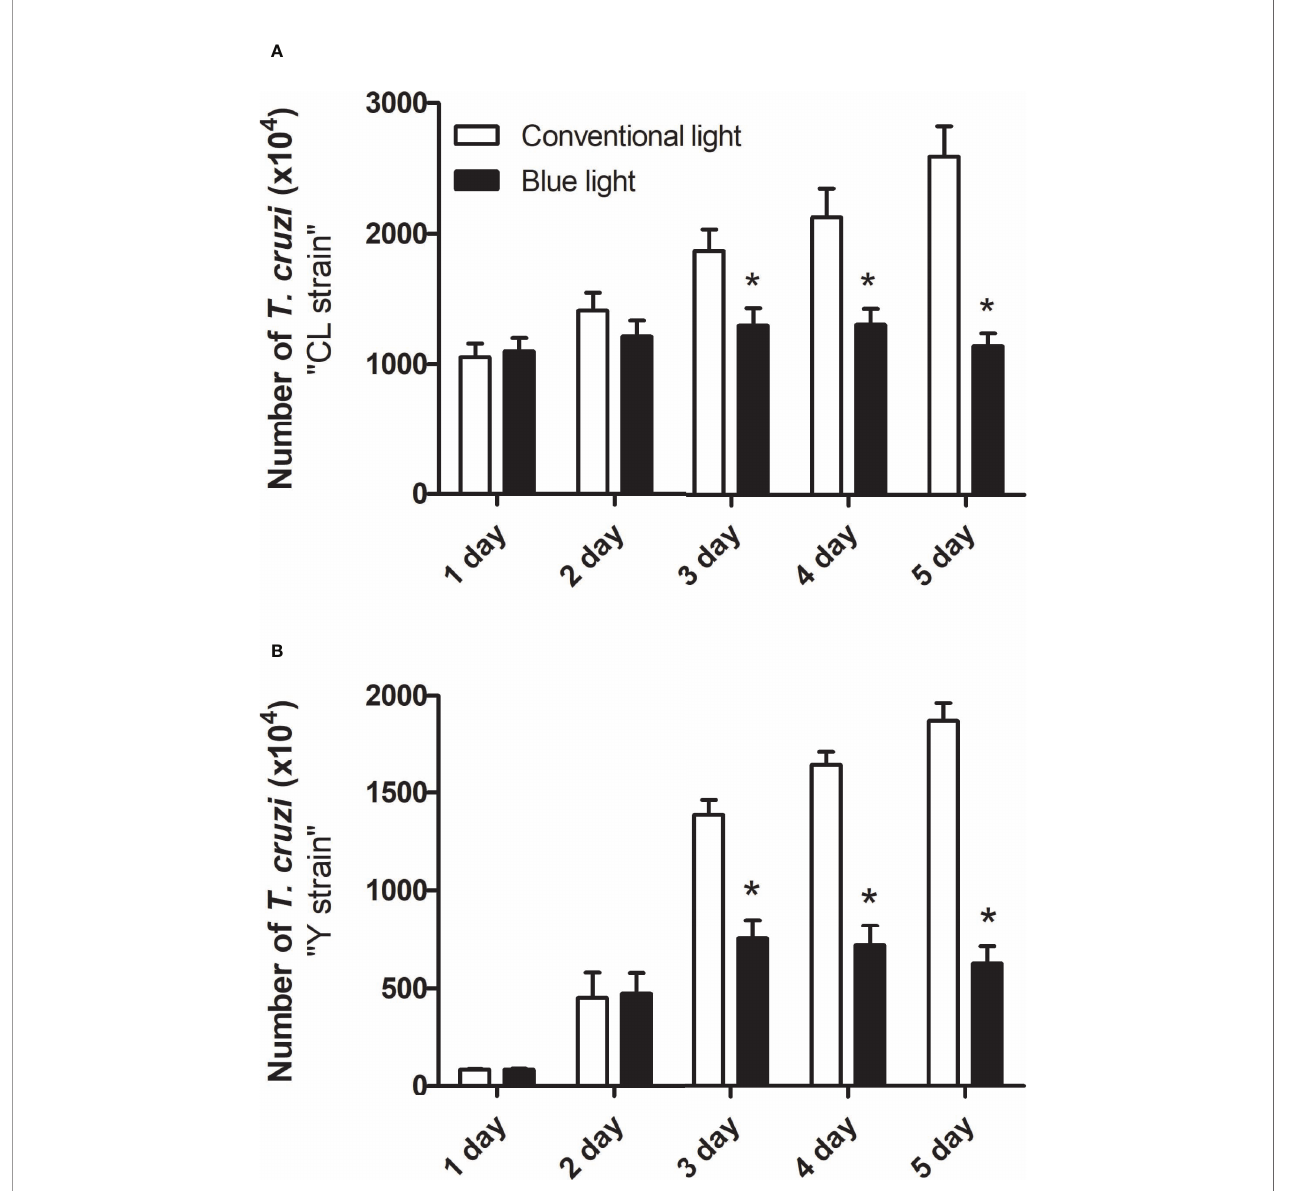
FIGURE 2 | Growth inhibition of the CL (A) and Y (B) strains of T. cruzi. The parasites cultures were exposed to phototherapy with blue light for 5 days 6h per day, at room temperature. The growth inhibition was evaluated in 10 µL every day using the neubauer chamber and a light microscope. *p<0.05 means differences between control groups and blue light